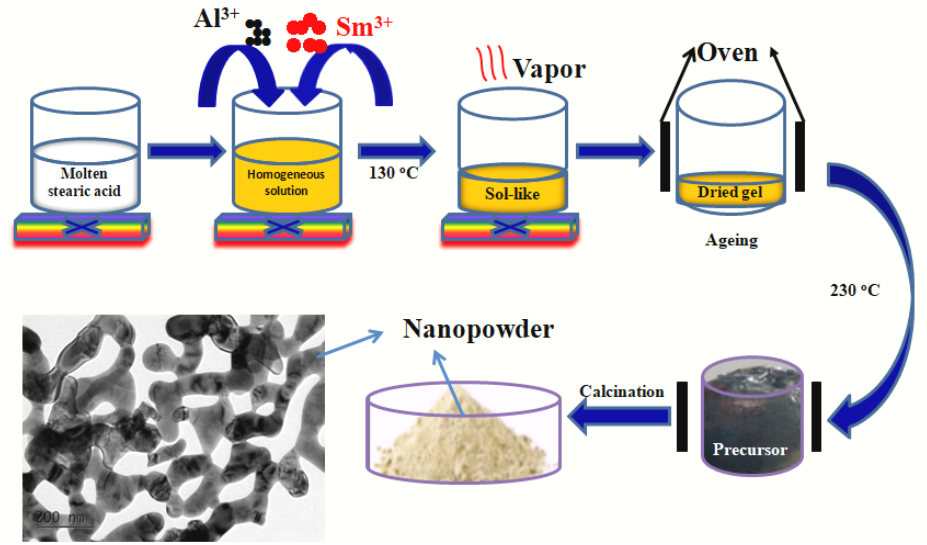
Fig. 1 Flow diagram of SmAlO 3 synthesized by the stearic acid